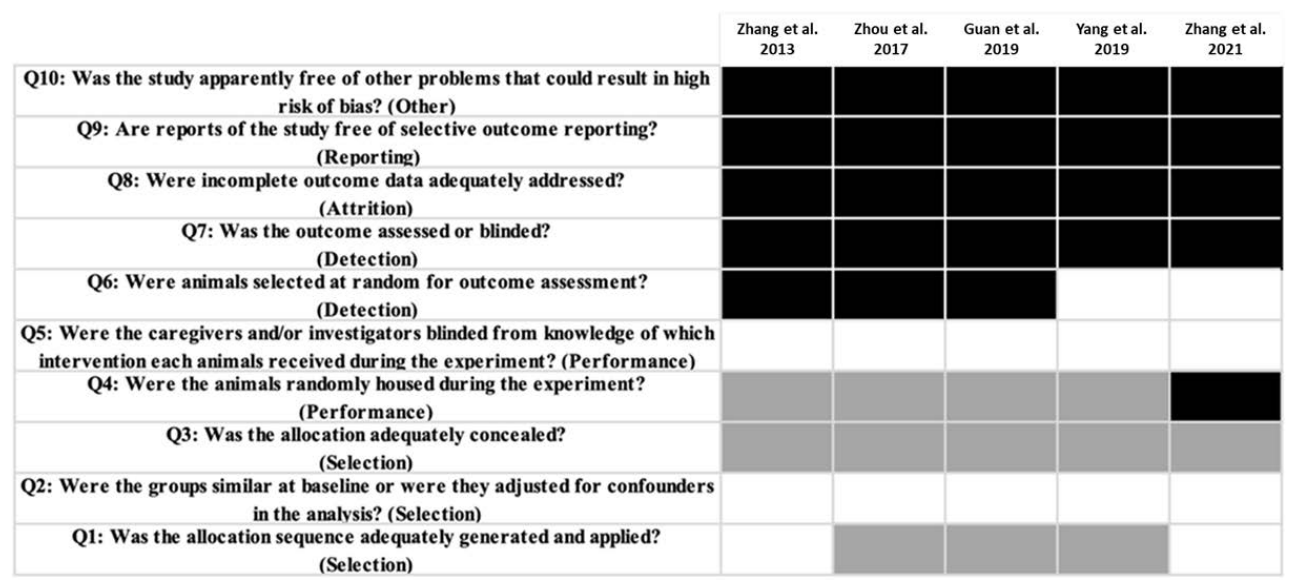
Figure 2. Risk of bias assessment results based on SYRCLE’s (Systematic Review Centre for Laboratory Animal Experimen- tation) risk of bias tool. White indicates low risk; black high risk; and gray unclear risk